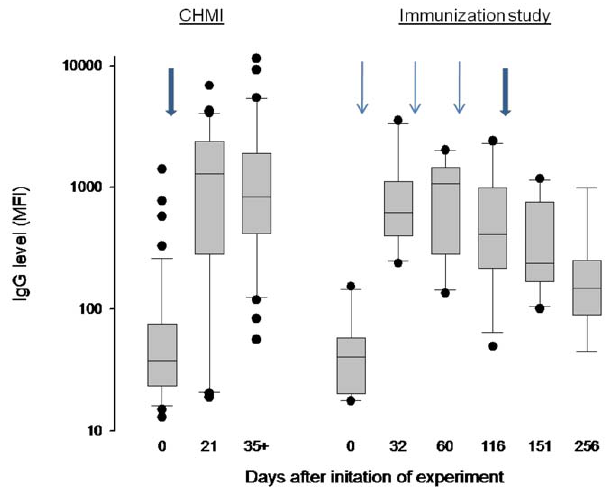
Figure 5. Acquisition of IgG to GLURP R2 during a liver stage immunization study. The anti-GLURP R2 IgG levels in 44 volunteers experimentally infected with Plasmodium falciparum (indicated by a thick arrow day one) and in 10 volunteers immunized by three exposures to P. falciparum while treated with chloroquine killing blood stage parasites (indicated by thin blue arrows day one, 33 and 61) and after challenge without a drug cover (thick blue arrow day 118). ‘‘35 + ’’ represents plasma samples taken 35, 42 or 90 days after infection. CHMI: